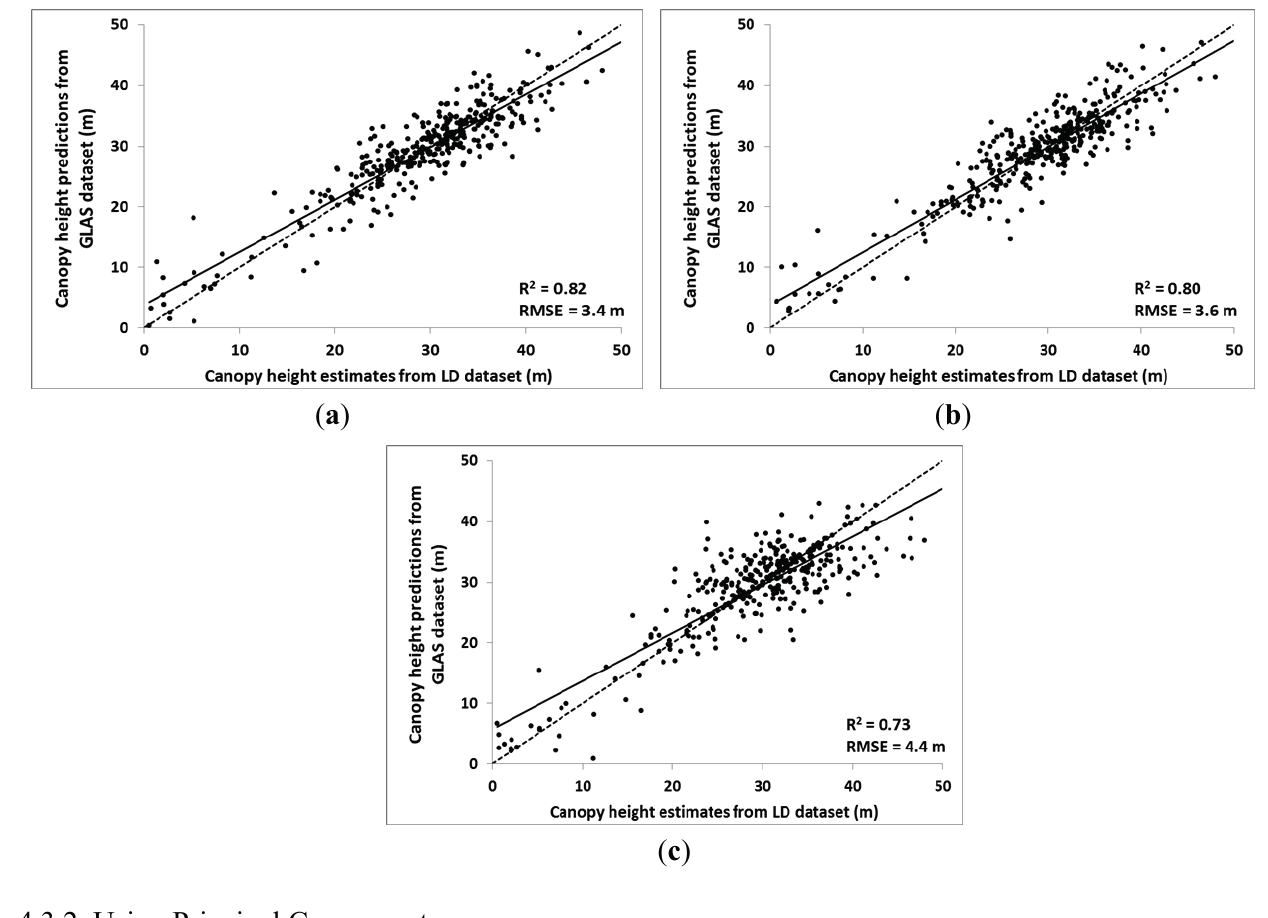
Figure 9. Comparison of estimated canopy heights using Random Forest regressions and estimated canopy heights from the LD dataset for three metrics